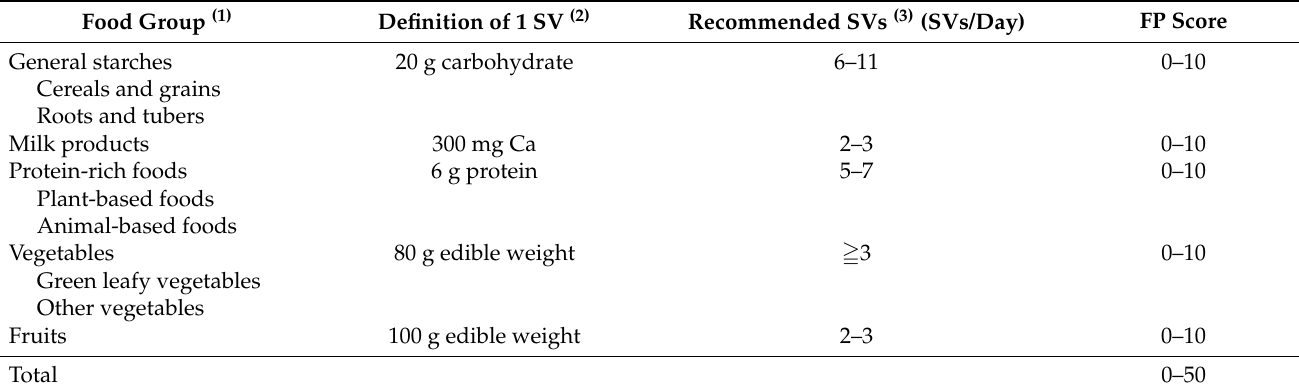
Table 1. Definition of 1 SV and the FP score criteria for each food